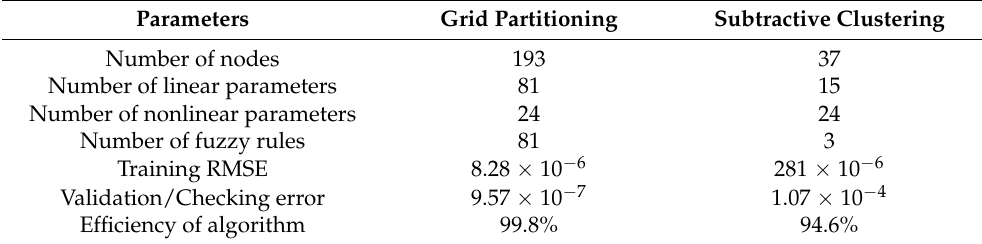
Table 8. Comparative study of GP and SC algorithms.